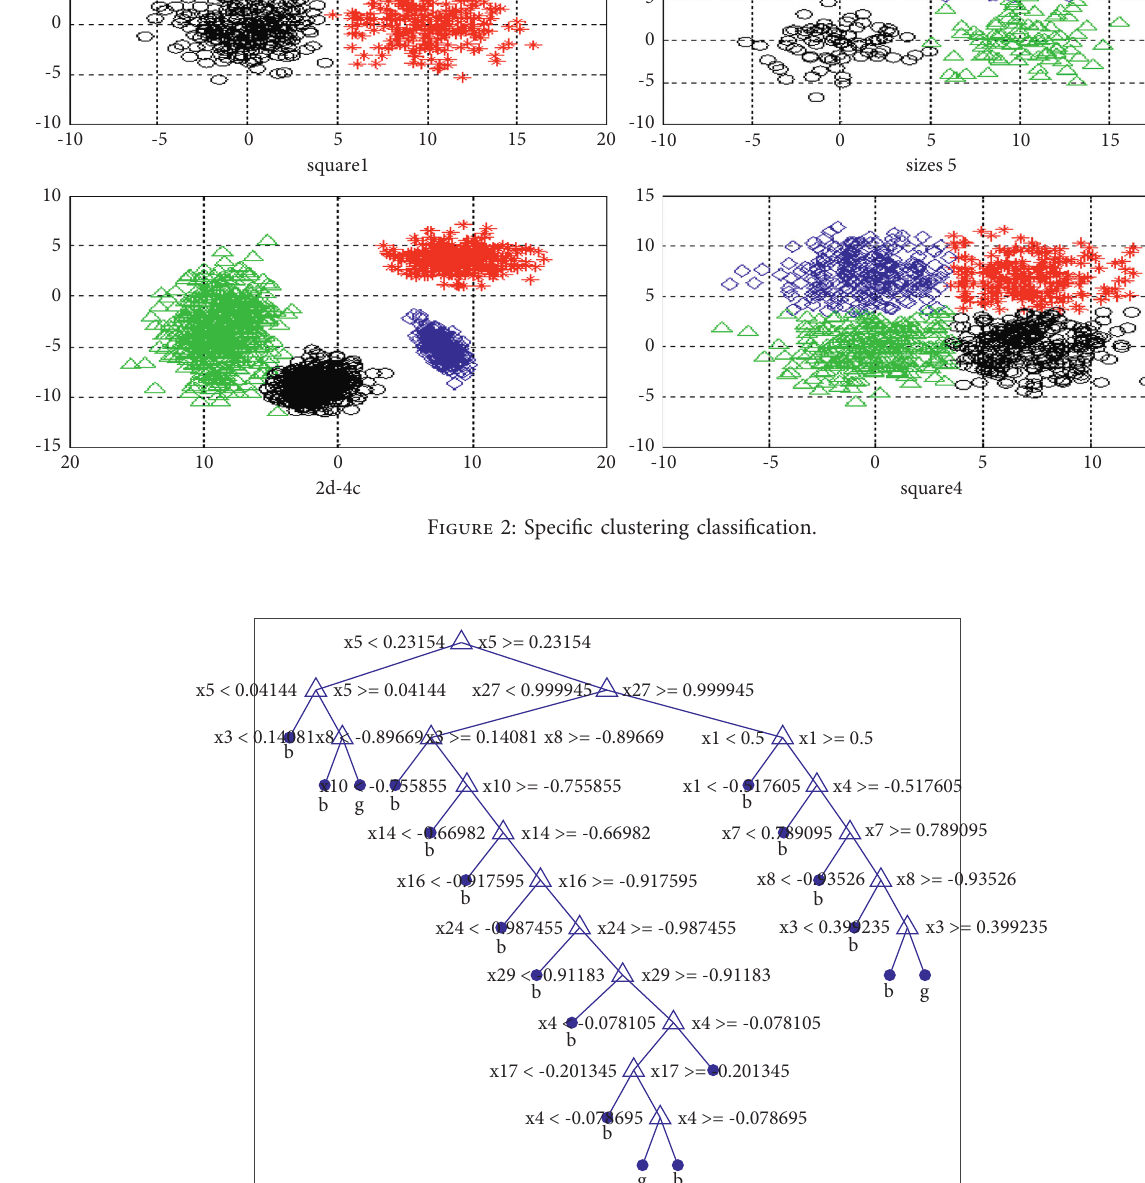
Figure 3: The biggest tree generation